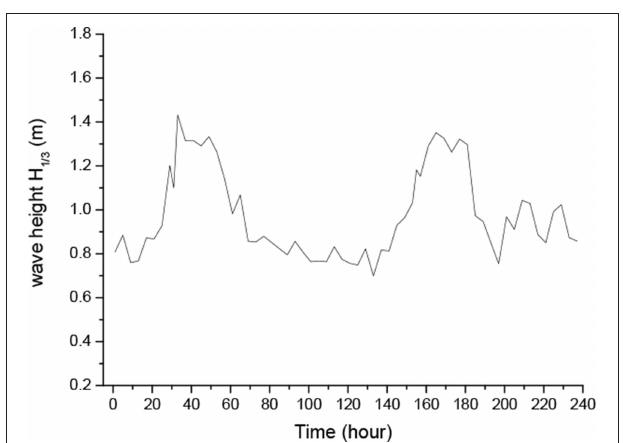
FIGURE 11 | Pitching motion of underwater substrate.